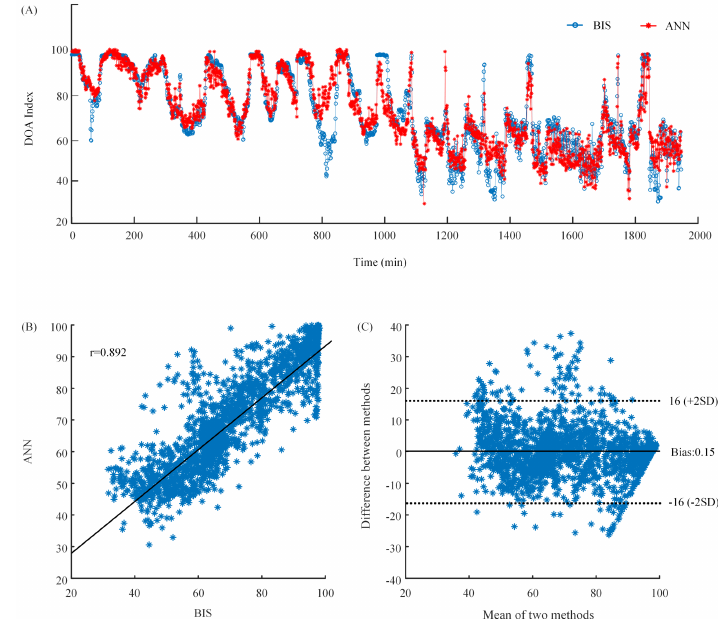
Figure 5. ( A ) The waveforms of BIS index and ANN output. The blue line is BIS index which is the target. The red line is ANN output which is the predicted value. ( B ) The scatter plot of BIS index and ANN output. ( C ) The Bland–Altman plot of BIS index and ANN